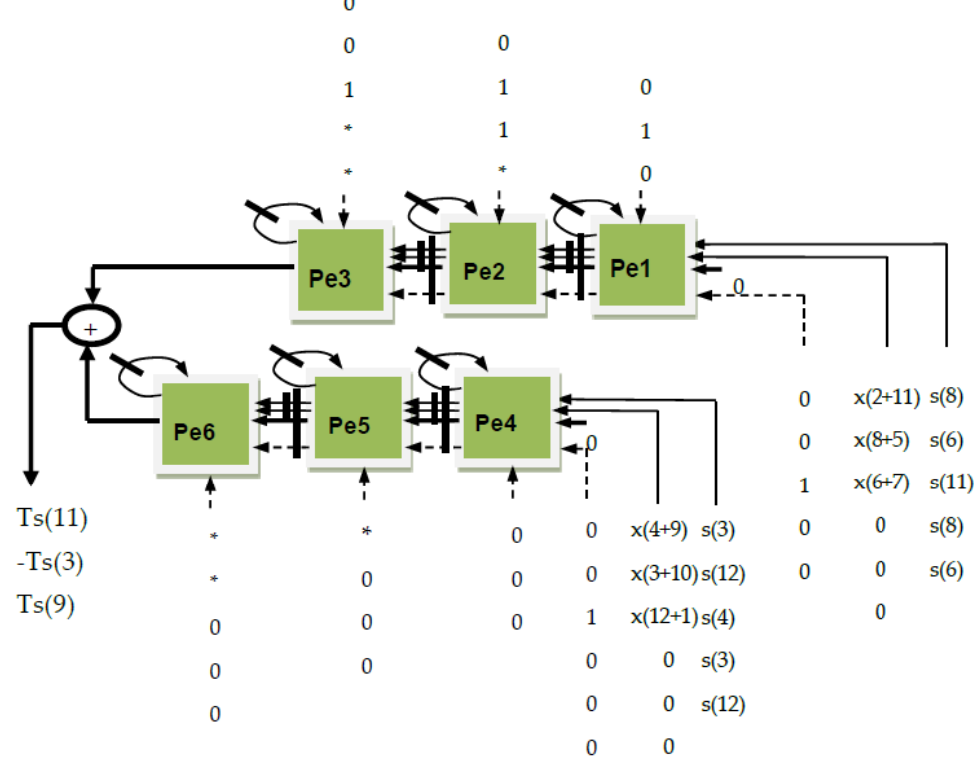
Figure 10. The VLSI architecture of the hardware core that implements Equation (33), where * marks a delay of one clock cycle. The pre-processing and post-processing stages implement Equations (28), (29) and (25) – (27), respectively, and the hardware core, which is shown in Figures 7 – 10, imple- ments Equations (30) –